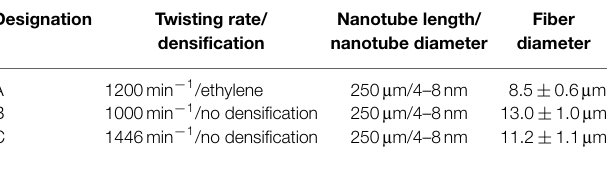
TABLE 1 | Characteristics of CNT fibers .